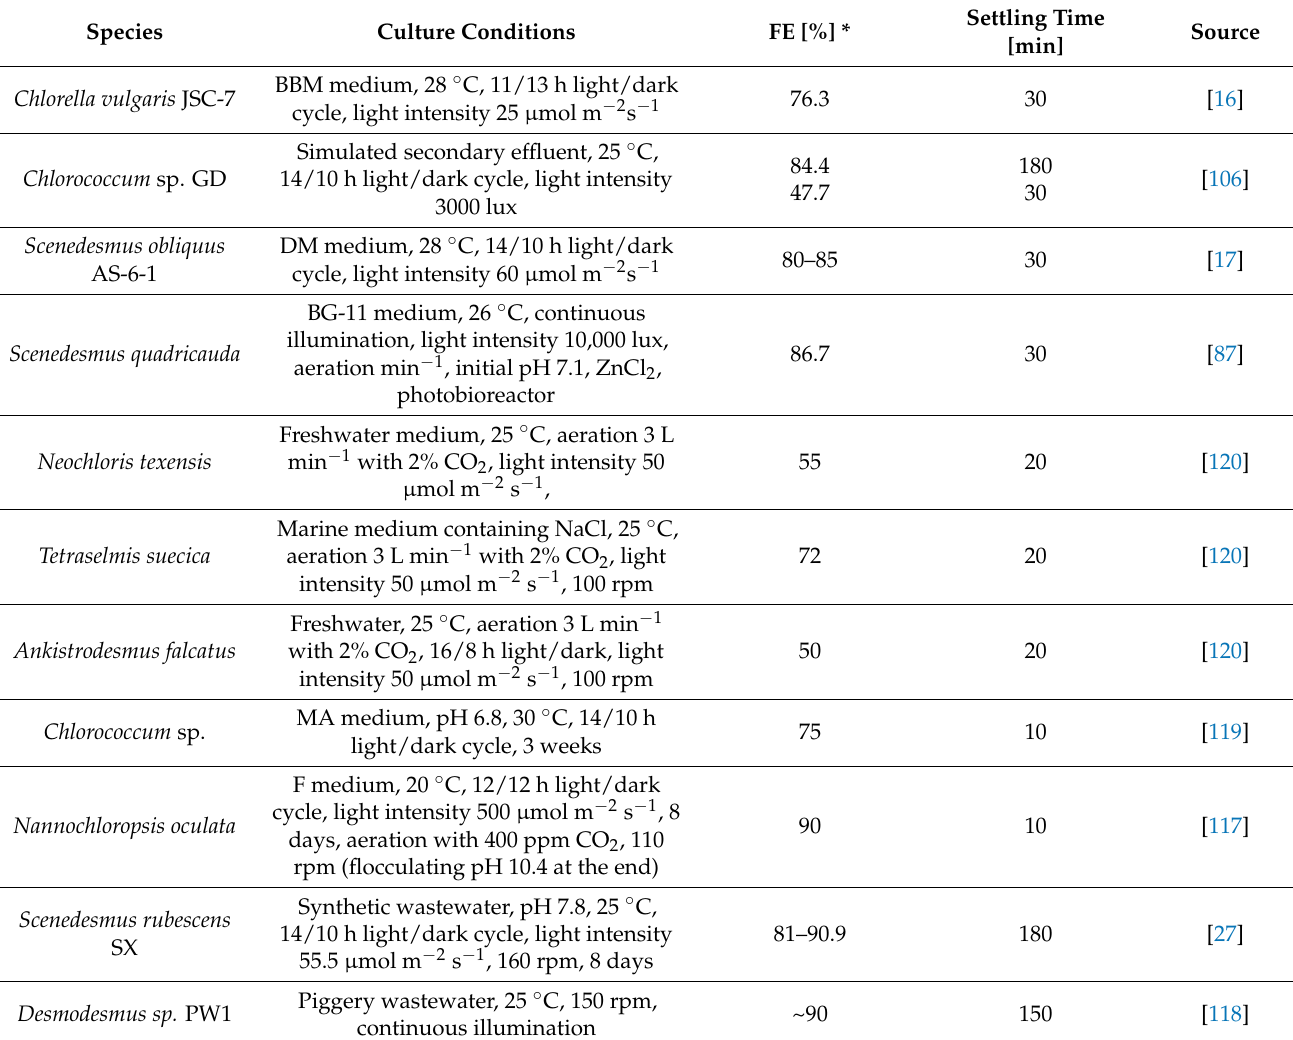
Table 4. Culture conditions and flocculation efficiency (FE) of